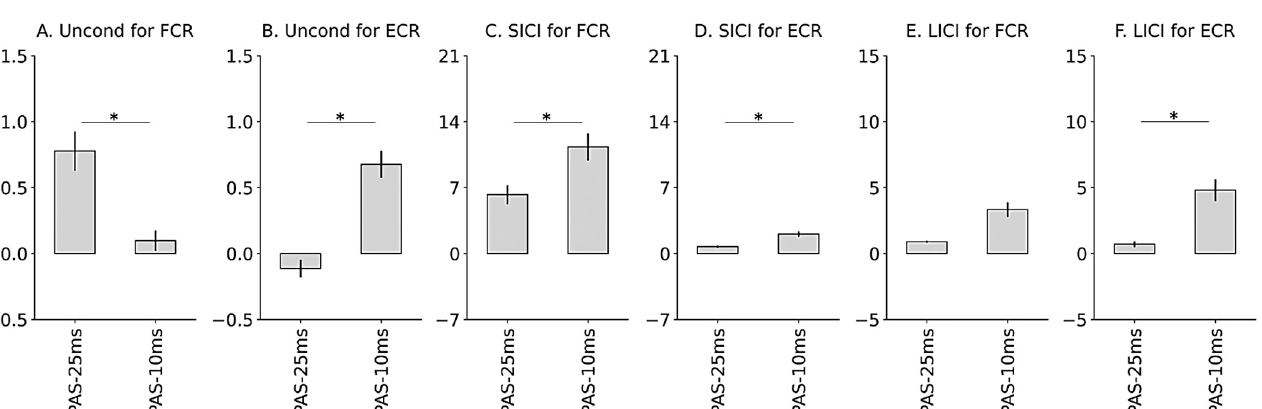
val intracortical inhibition; LICI, long-interval intracortical inhibition.